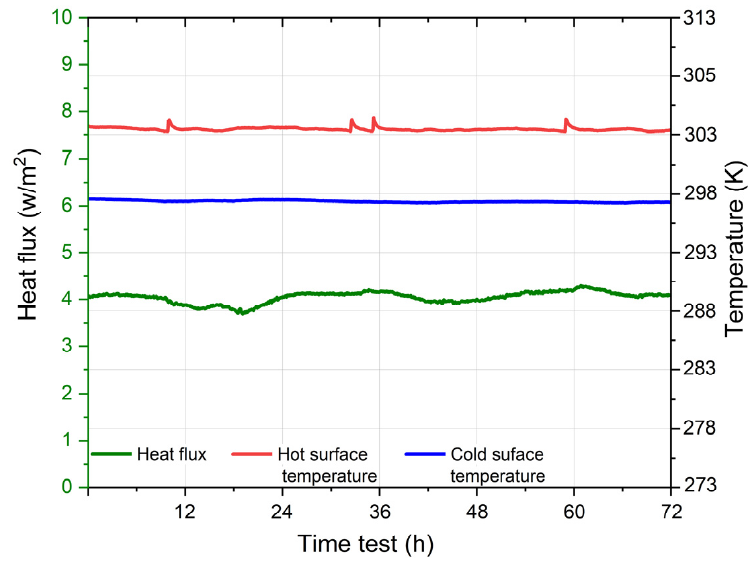
Figure 5. Hotbox test results for giant-reed board I-55.